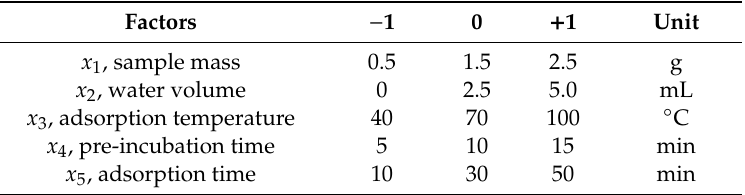
Table 2. Selected factors and their